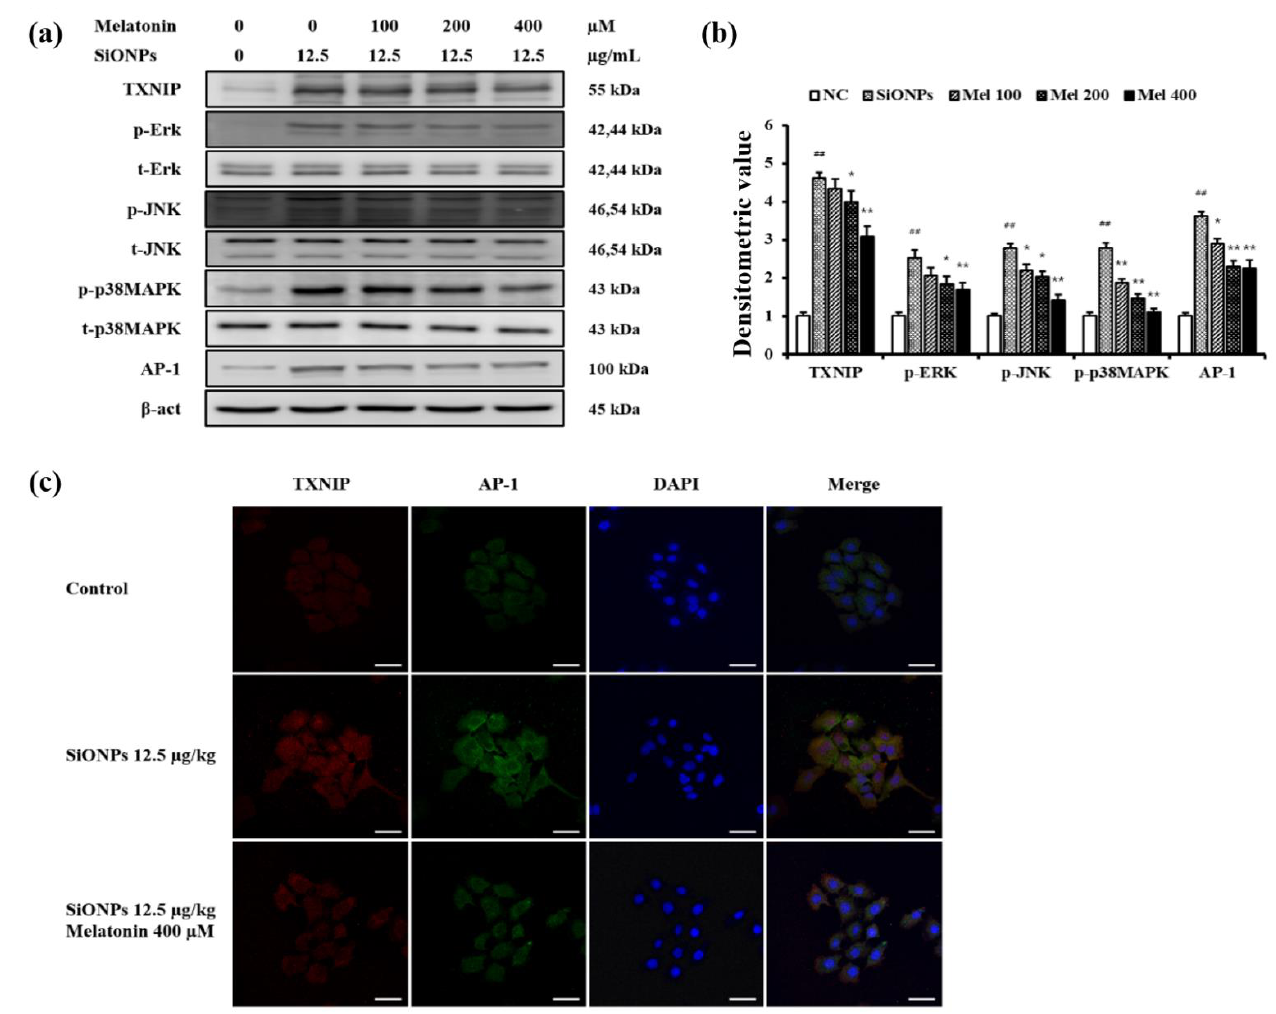
Figure 7. Melatonin inhibited the activation of TXNIP/MAPK/AP-1 pathway in SiONPs-stimulated cells. ( a ) Representative figure for Western blot, ( b ) densitometric value, ( c ) immunofluorescence for TXNIP and AP-1. Densitometric expression value of each protein was quantified using Chemi-Doc (Bio-rad). Scale bars = 25 µ m ( n = 3). ## p < 0.01, vs. non-exposed cells; * p < 0.05, ** p < 0.01, vs. SiONPs-stimulated cells.